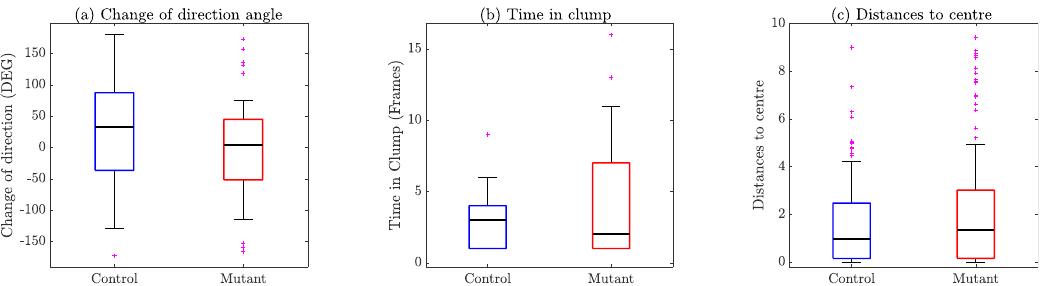
Figure 11. Comparison of relevant variables between control (blue) and mutant (red) interactions. ( a ) Change of direction angle, θ x , coming from Figure 10. ( b ) Time in clump TC in frames. Finally, ( c ) shows the distances to the centre or origin of the new frame of reference ( x (cid:48) , y (cid:48) ) (i.e., the length of the tracks after they leave the clump.